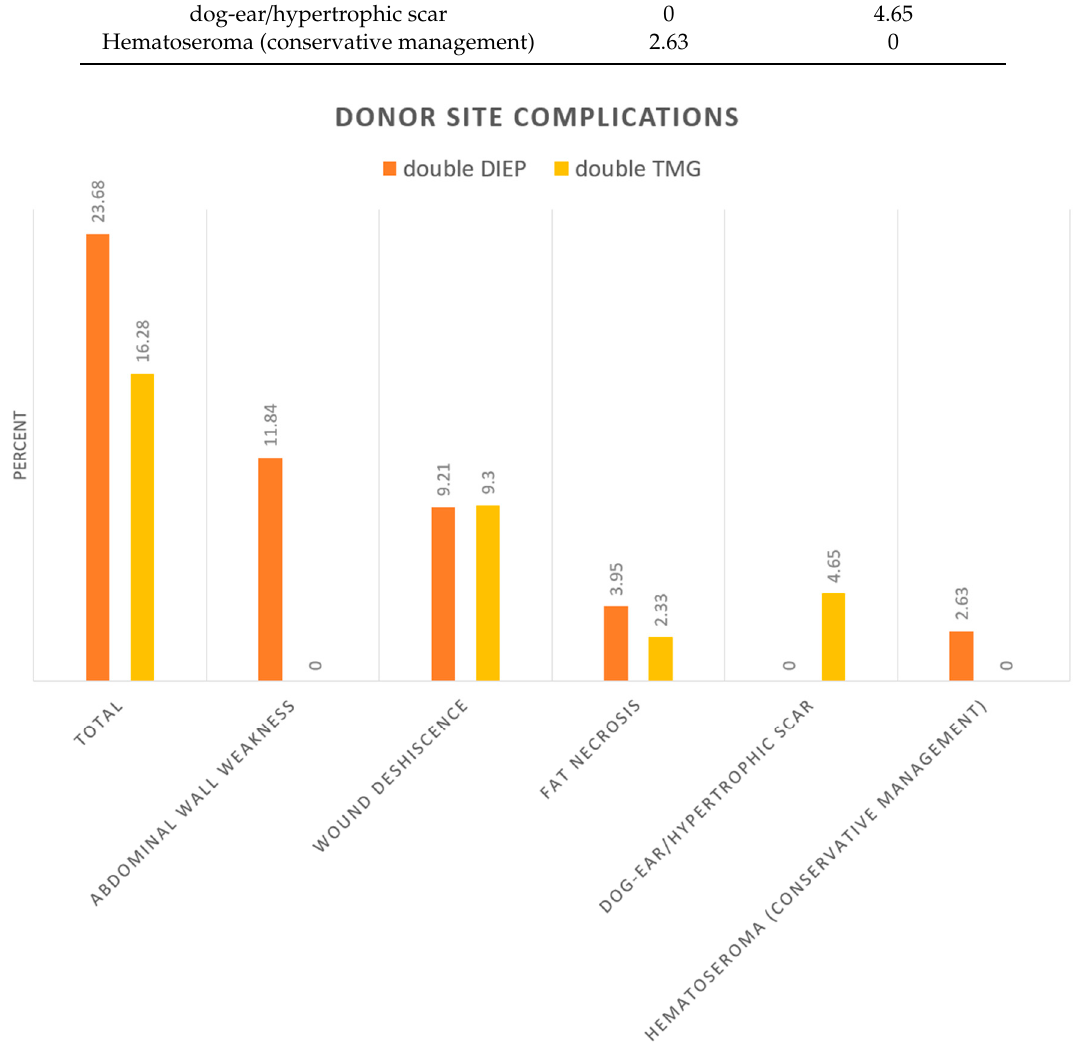
Figure 5. Donor site morbidity in detail.